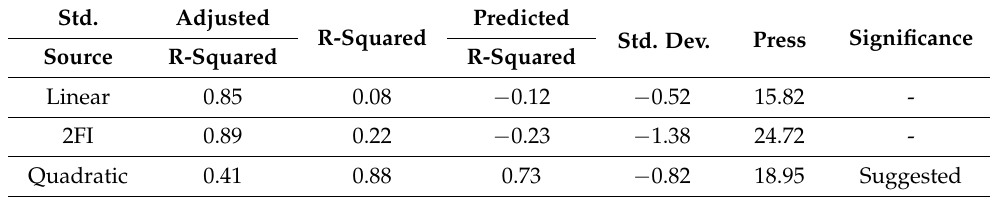
Table 7. Optimal response model analysis based on the value of accuracy and R-squared value of fitting